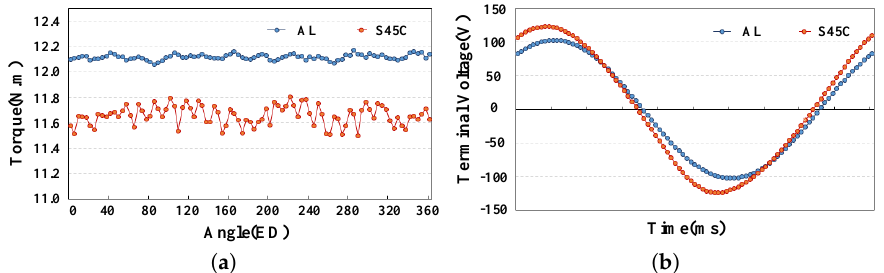
Figure 7. Electromagnetic torque and terminal voltage waveform of the motor during rated operation. ( a ) Electromagnetic torque. ( b ) Terminal